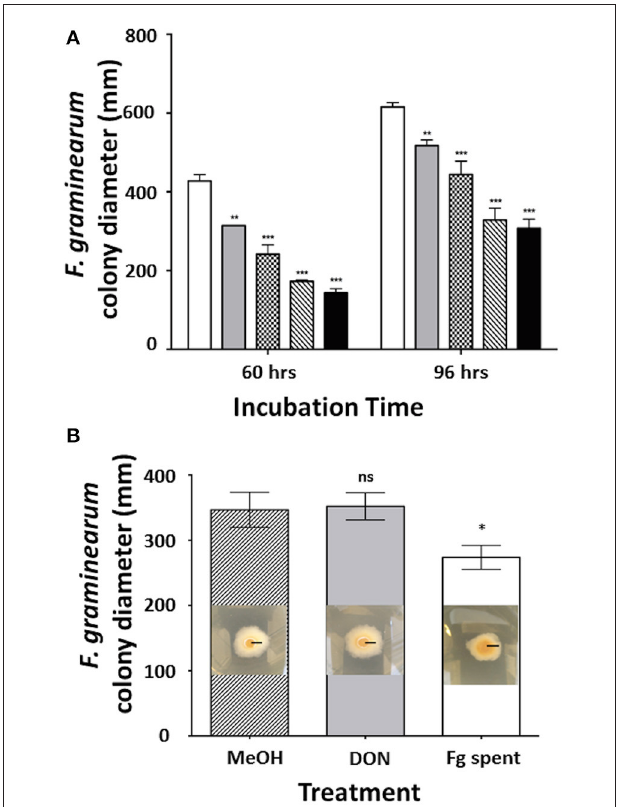
FIGURE 1 | Effect of filter-sterilized secretomes on the C. rosea AMC941 - F. graminearum interaction. (A) Effect of increasing concentration of filter-sterilized C. rosea ACM941 culture broth (representing its secretome) on F. graminearum colony size after 60 and 96h incubation. Bars represent: white: F. graminearum grown on PDA plate overlaid with 2.25ml of Czapek Dox broth (control); and gray, plaid, diagonal stripe, black: F. graminearum grown on PDA plates overlaid with 375, 750, 1,500, and 2,250 µ l of filter-sterilized C. rosea- spent media, respectively. Asterisks indicate level of significance at p < 0.001 and error bars indicate standard error ( n = 3). (B) Effect of DON and Fusarium- spent media treatment (applied during the production of C. rosea ACM941 spent-media) on the growth-inhibitory activity of C. rosea ACM941 spent-media. Shown are representative images of F. graminearum grown on PDA plates overlaid with sterilized C. rosea -spent-media obtained after growth in the presence of (i) methanol, (ii) 5 ppm DON, and (iii) 1,000 × diluted F. graminearum spent media containing live macroconidia. Black bar indicates 1cm. These are embedded in a quantitative plot of the data obtained. Asterisks indicate level of significance at p < 0.001 and error bars indicate standard error ( n =